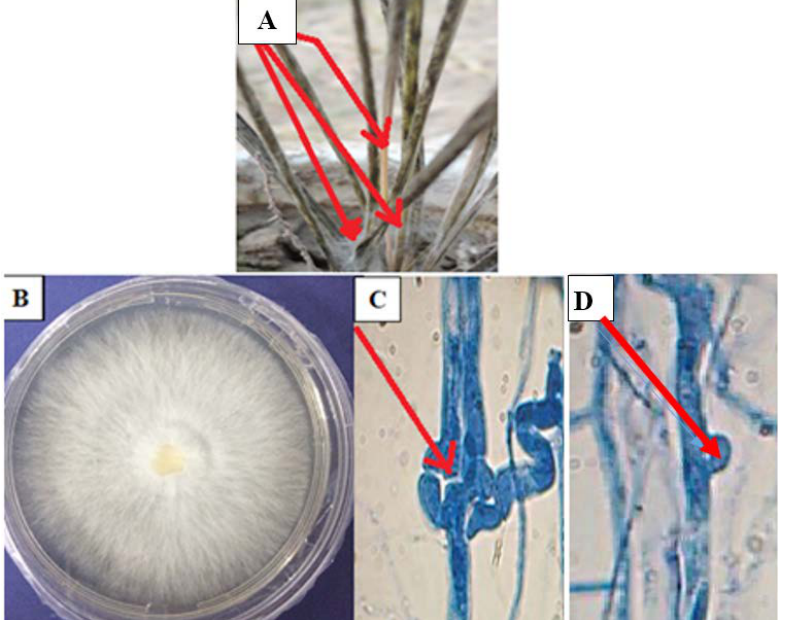
Fig. 1. Disease symptoms of wilt disease caused by M. palmivorus on I. cylindrical plants at 15 days after inoculation (A), morphological feature of M. palmivorus growing on PDA at 28 ± 2 o C after 4 days of incubation (B), septal wall of fungal hyphae (C), and clamp connections (D), under a light compound microscope, 25 µm (40X -1 at 10 days after